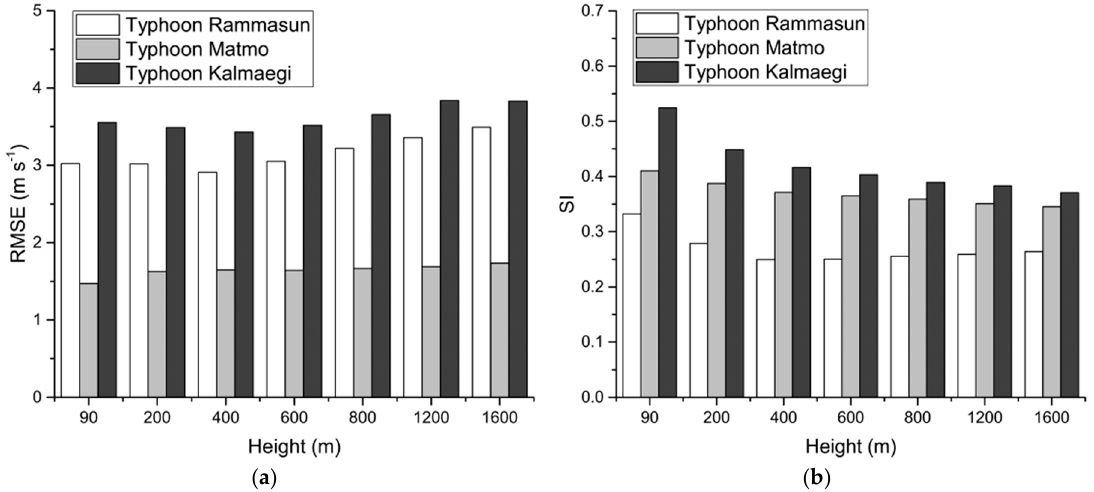
Figure 6. The error indicators in the three typhoon simulations: ( a ) the RMSE ; and ( b ) the SI .